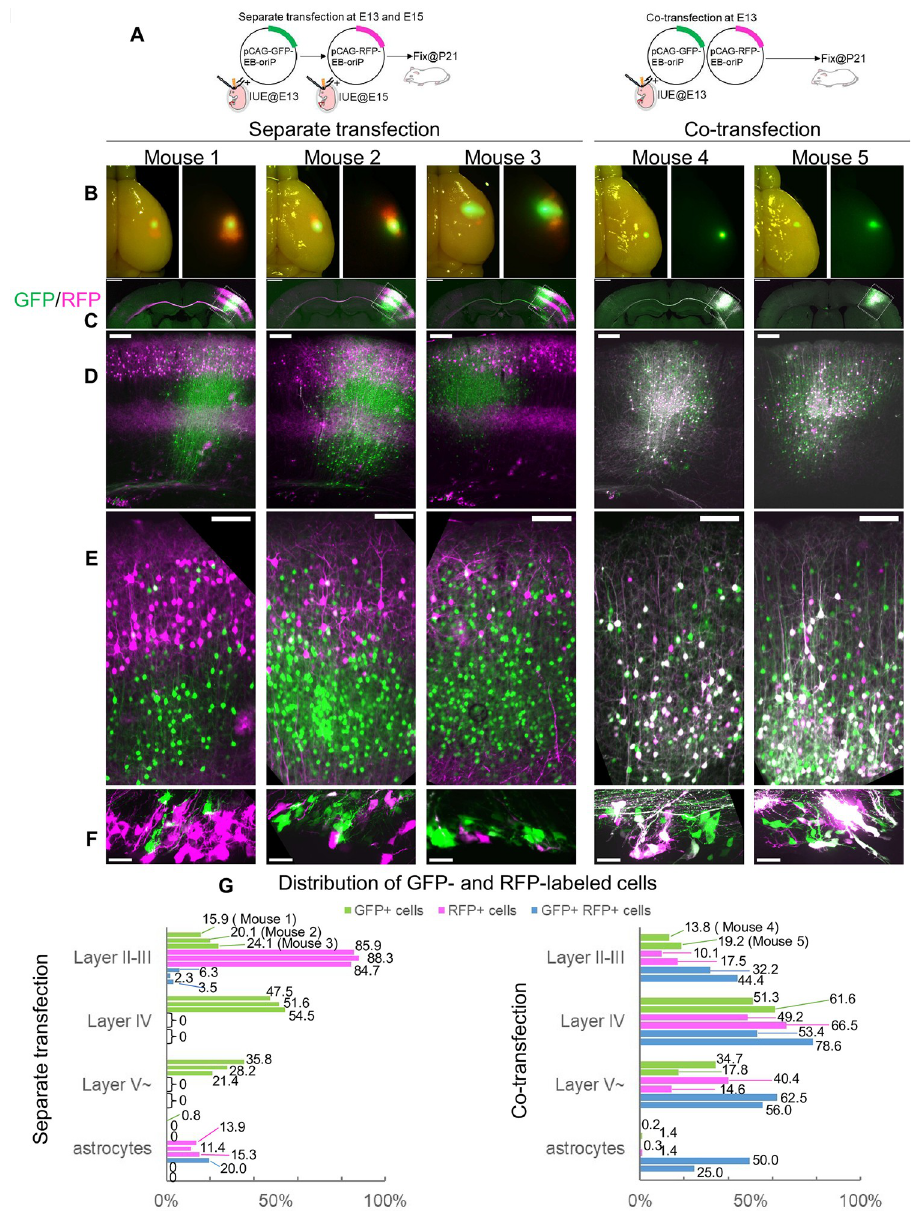
Fig 5. NPCs susceptible to IUE at E13 might be less susceptible at E15. (A) Schematic illustration of the experiment. IUE of the EB-oriP plasmids encoding either GFP or RFP was performed twice at E13 and E15 (separate transfection, left) or once at E13 (co-transfection, right). Transfected brains were analyzed at P21. (B) Individual images of the successful transfection. Merged fluorescence image of GFP and RFP (right panels) were merged with bright-field image (left panels). (C–F) (C) Merged fluorescence images of GFP and RFP of the coronal sections from the brains with separate transfection (left) and co-transfection (right). The boxed regions were magnified and are shown in (D). Magnified images of the superficial regions (E) and V-SVZ (F). Scale bars: 1 mm in (C), 200 μ m in (D), 100 μ m in (E), 25 μ m in (F). (G) Quantification of the distributions of GFP- and RFP-labeled cells per animal (separate transfection, Mouse 1, n = 604 (GFP), n = 710 (RFP); Mouse 2, n = 2369 (GFP), n = 446 (RFP); Mouse 3, n = 2032 (GFP), n = 333 (RFP); co-transfection, Mouse 4, n = 854 (GFP), n = 606 (RFP); Mouse 5, n = 281 (GFP), n = 212 (RFP)). Two to five sections from the central part of the transfected region per animal were